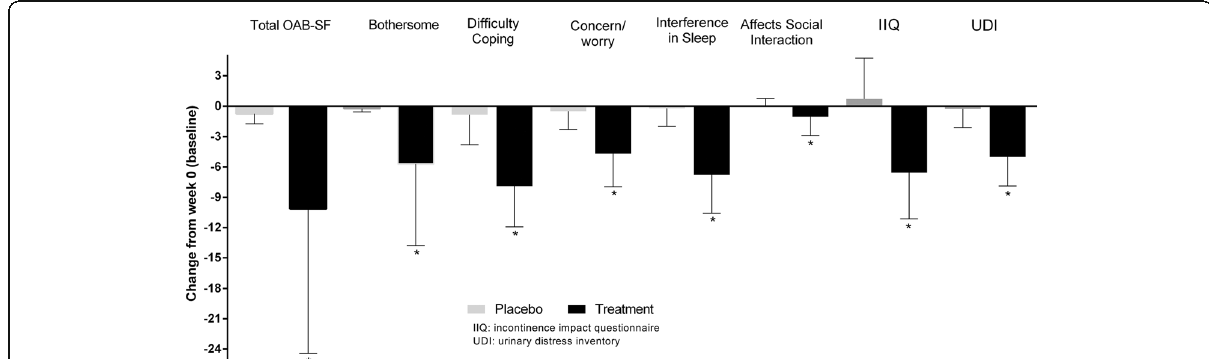
Fig. 3 HR-QOL scores at week-8 on placebo and the Urox treatment. *Significantly different from placebo when compared as change from